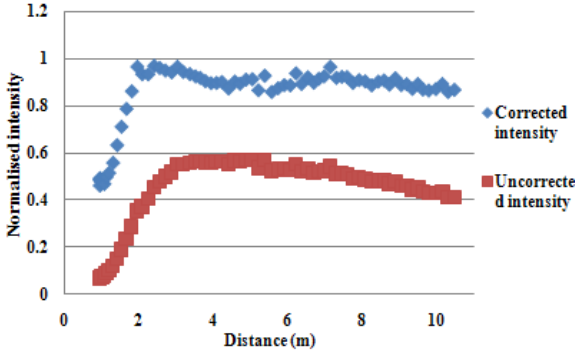
Figure 3. Snow depth measured manually (with snow stick), snow depth sensor measurements (FMI-ARC) and TLS profiles at Tähtelä. The laser point measurements were made at different location than the other measurements.